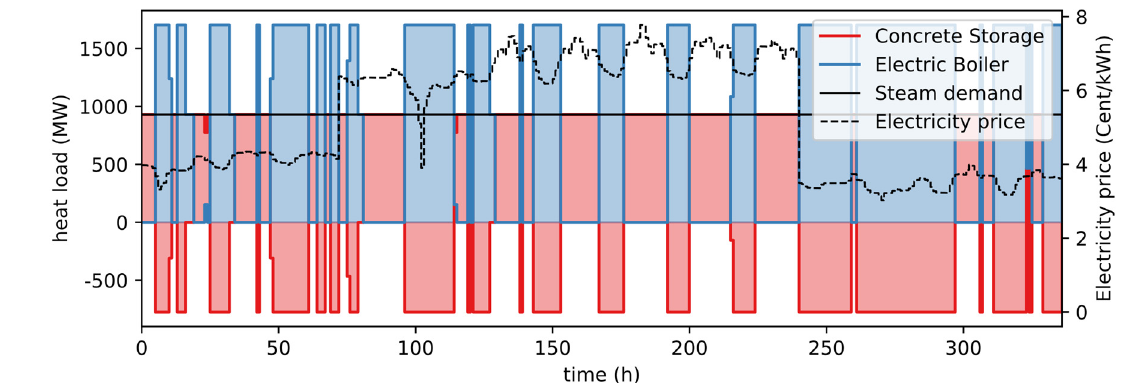
Figure 11. Storage and steam generator loads, steam demand and electricity price profiles for Case 1 during dry season.